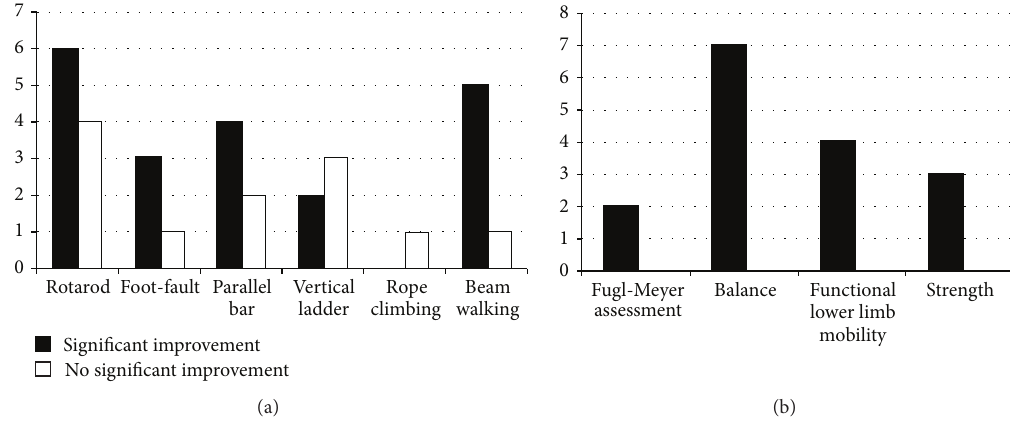
Figure 2: Effects of AE on balance and locomotor/lower limb coordination. (a) Animal studies ( 𝑛 = 22 ) are presented as the frequency of AE-induced positive (black bars) and negative (white bars) findings. (b) Clinical trials ( 𝑛 = 9 ) predominantly reported positive findings (black bars) in both experimental and control groups: outcomes included Fugl-Meyer assessment, balance (e.g., Berg Balance Scale, limits- of-stability test), functional lower limb mobility (e.g., get-up and go test, sit-to-stand test, and turning speed), and